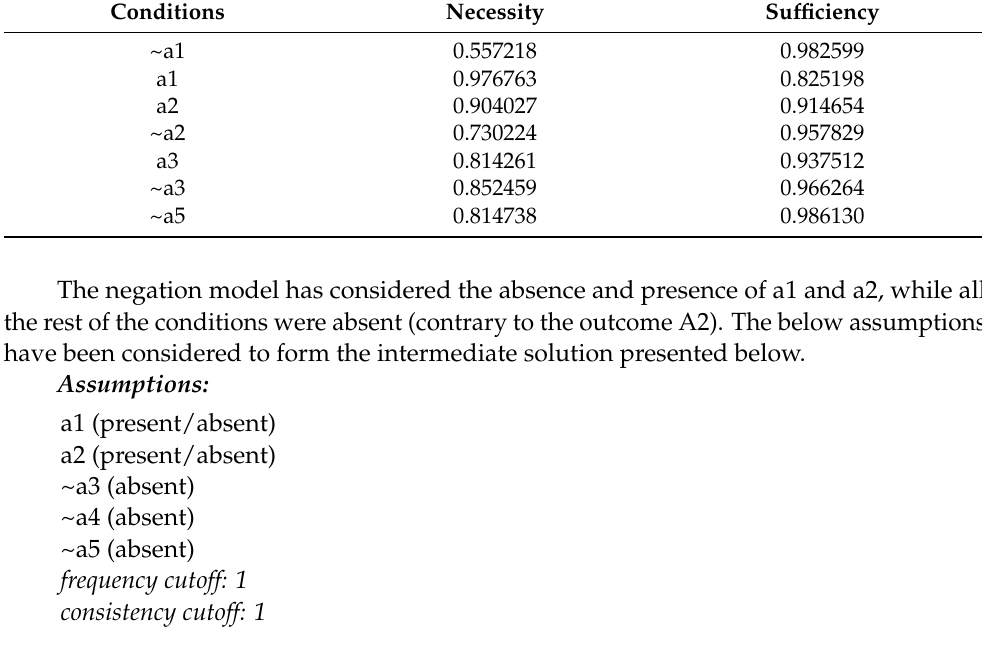
Table A10. Failure pathways (outcome A2)- The mark * resembles “and”. Solutions